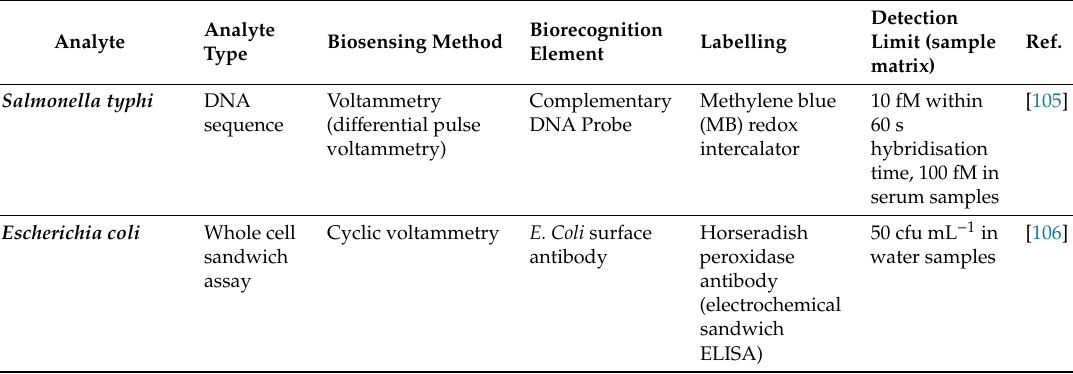
Table 2. Examples of proof-of-concept electrochemical